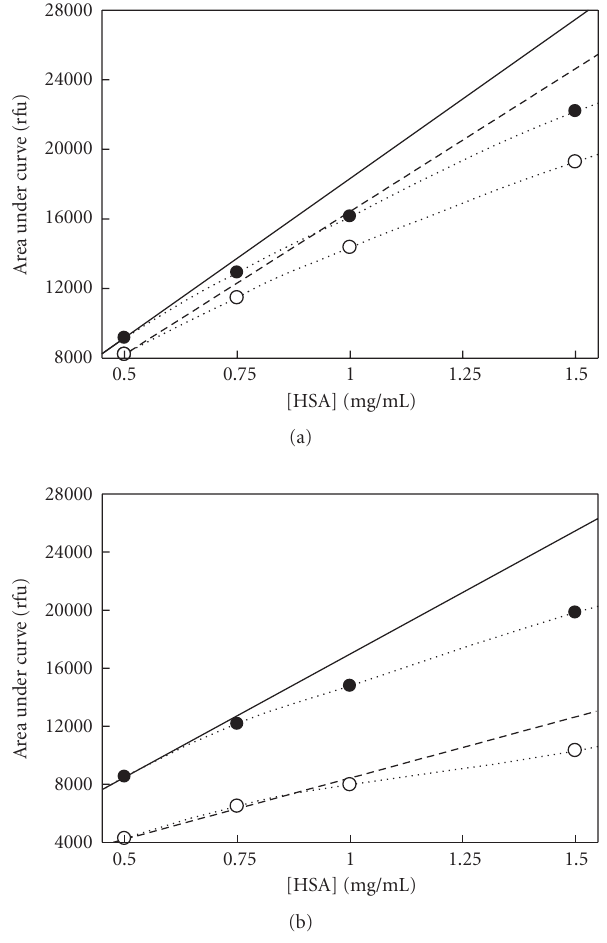
Figure 2: Observed fluorescence shown relative to projected unquenched maxima. Extrapolation of regression lines were drawn from fluorescence data that were obtained at low HSA concentra- tions from control (solid line), sevoflurane-[A] and isoflurane [B]- treated (dashed line) samples. The projected unquenched maxima are compared with data (dotted line) observed at the concentrations shown (control, closed circles; sevoflurane-[A] and isoflurane [B]- treated, open circles). The di ff erence between the regression lines and the dotted lines represents